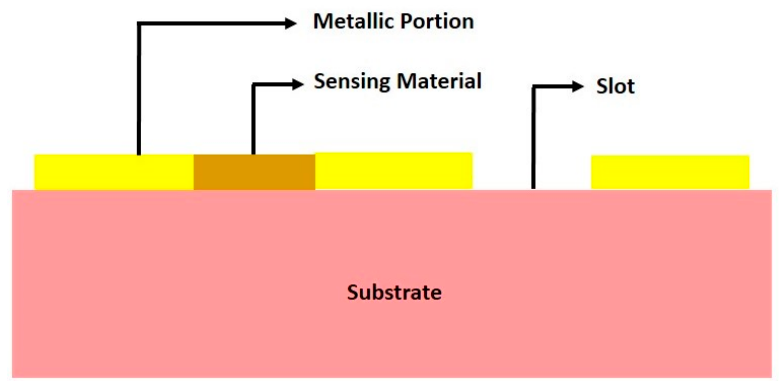
Figure 14. Cutting plane view of a portion of the proposed moisture sensor tag.